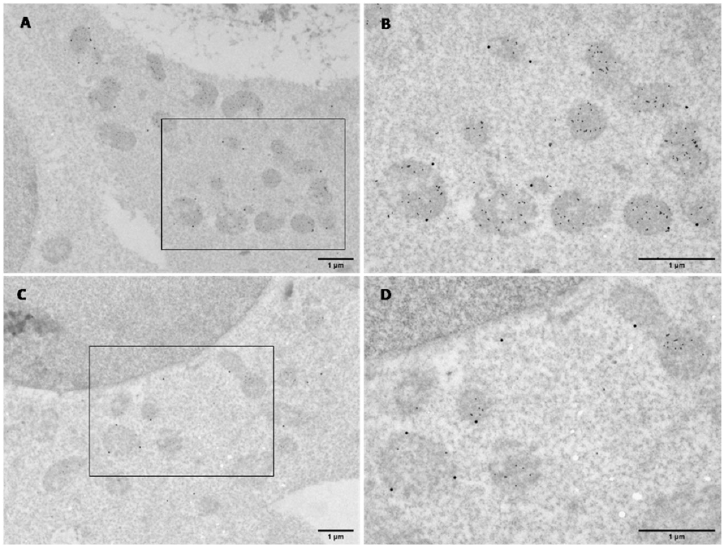
Figure 7. Electron micrographs of dual immunogold labelling in transfected HEK293T cells for 48 h. Cells were co ‐ transfected and co ‐ probed with anti ‐ KMO antibody (10698 ‐ 1 ‐ AP) and anti ‐ HTT (mEM48) antibody (MAB5374), followed by 30 and 15 nm gold conjugate secondary antibodies, respectively. ( A,C ) Overview of dual labelling of flKMO ‐ CC and 19Q ‐ VN, respectively. Scale bar = 1 μ m. ( B,D ) Zoomed view of the regions indicated by the black box in A and C, respectively. Mitochondria are all intensely labelled with HTT (15 nm particles), and some particles are seen in the cytoplasm. flKMO ‐ CC labelling is seen on the outer membrane of some HTT ‐ labelled mitochondria (30 nm particles). Scale bar = 1 μ m.